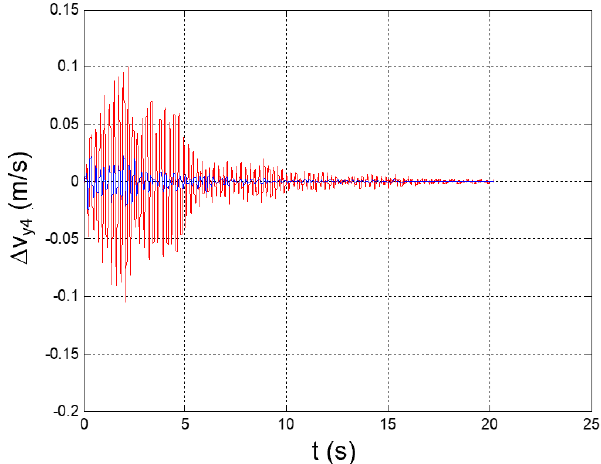
Figure 39. Seismic response, interstory speed at the 4th floor ( Δ 𝑣 y4 = 𝑣 y4 − 𝑣 y3 ).